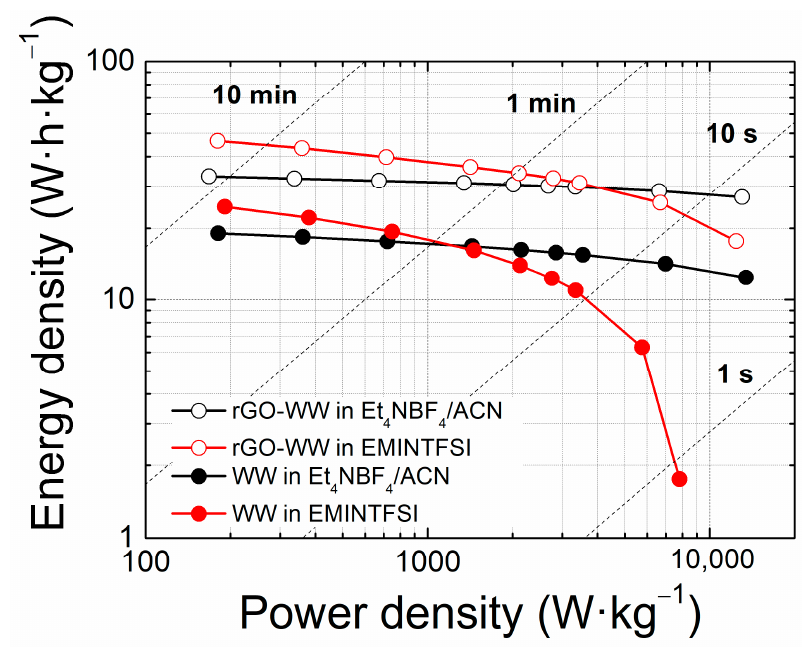
Figure 6. Ragone plot of indicated samples in both electrolytes.